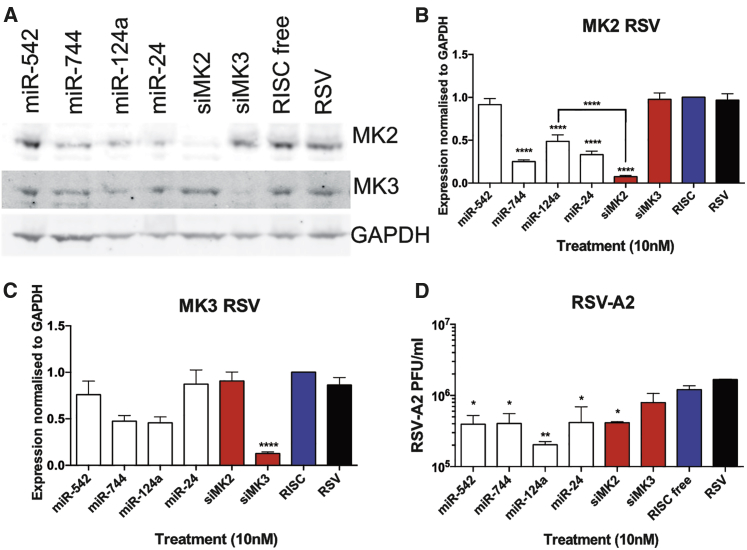
Role of MK2 Suppression in RSV Infection(A) Representative western blot analysis of MK2 and MK3 expression in A549 cells transfected with 10 nM miRNA mimics, siMK2, siMK3, or controls for 48 hr. Cells were subsequently infected with RSV-A2 at MOI 3 for 24 hr. (B and C) Quantitative analysis of (B) MK2 or (C) MK3 total protein levels in RSV infection normalized to GAPDH shown as the mean ± SEM of n = 4. (D) RSV viral titers are shown as the mean ± SEM of n = 3. Significant differences between RISC-free siRNA control and miRNA or siRNA treatments are indicated (*p < 0.05, **p < 0.01, and ****p < 0.0001, one-way ANOVA).